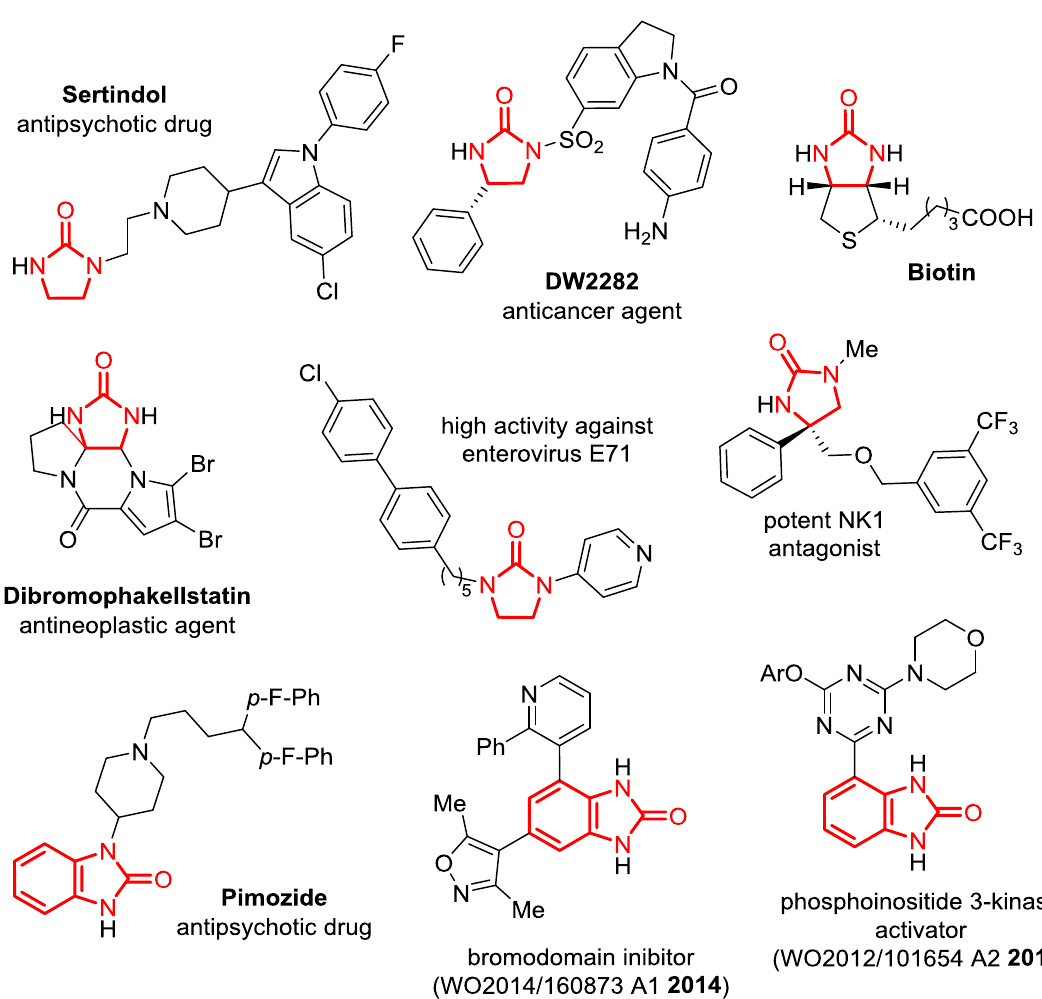
Figure 1. Selected 2-imidazolidinone and 2-benzimidazolidinone-containing bioactive compounds.